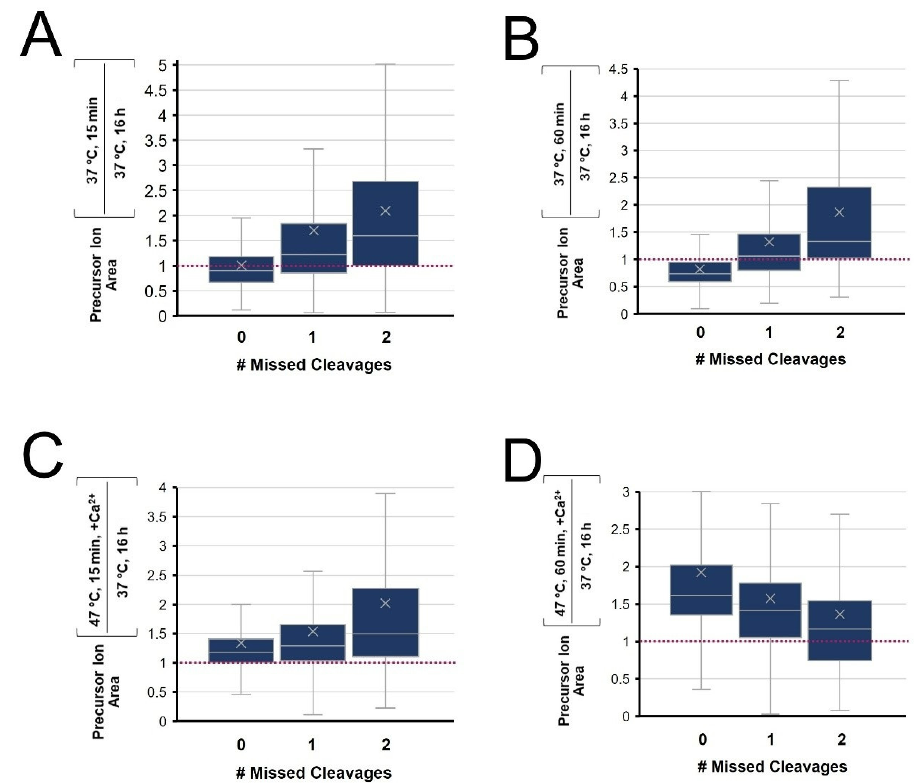
Figure 7. Tukey Box ‐ and ‐ Whisker plots of the distribution of relative peptide peak areas following digestion at ( A ) 15 or ( B ) 60 min, each at 37 °C with no added calcium or at 47 °C with 10 mM added calcium for ( C ) 15 or ( D ) 60 min. The relative peak intensity is compared to a conventional overnight digest at 37 °C.